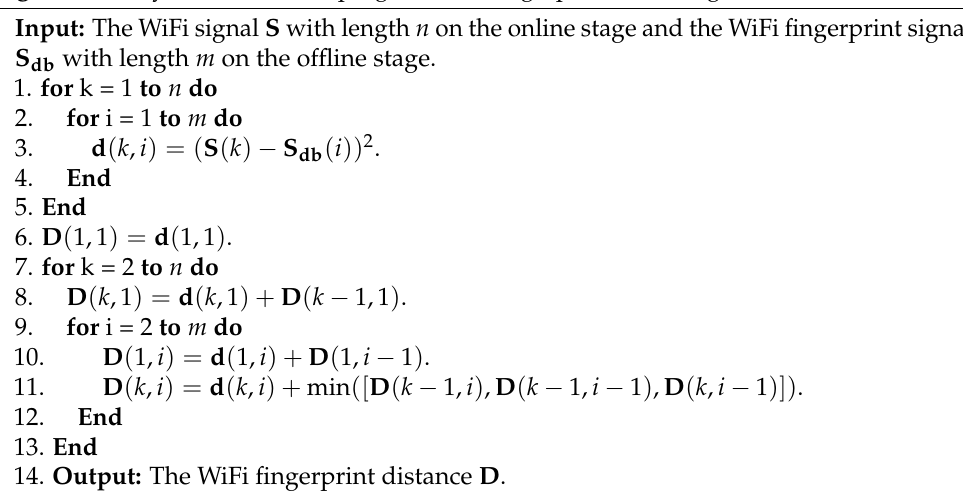
Algorithm 1 Dynamic time warping for WiFi fingerprint